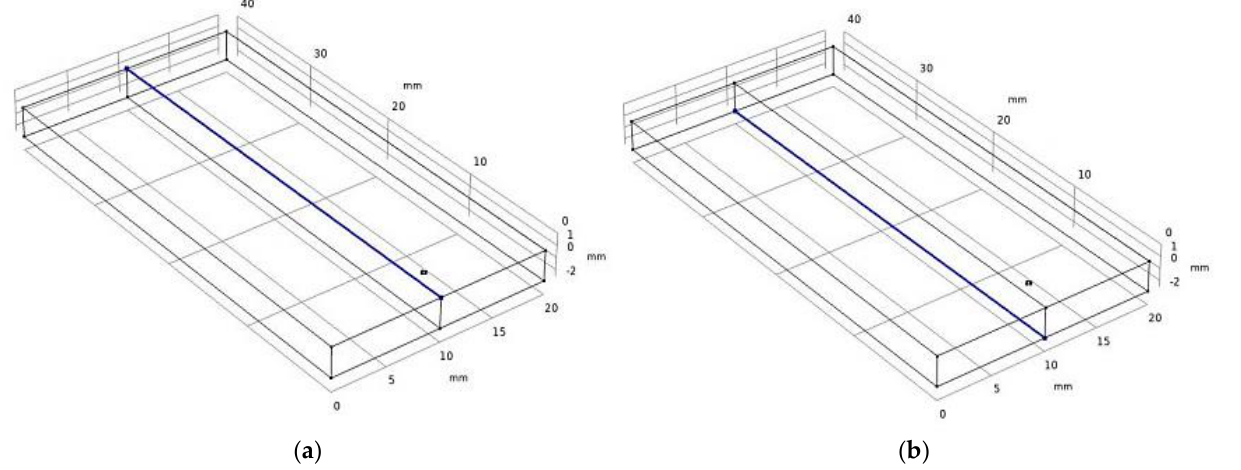
Figure 12. Edge temperature probe along the direction of welding: ( a ) z = 0 and ( b ) z = – 2.5.